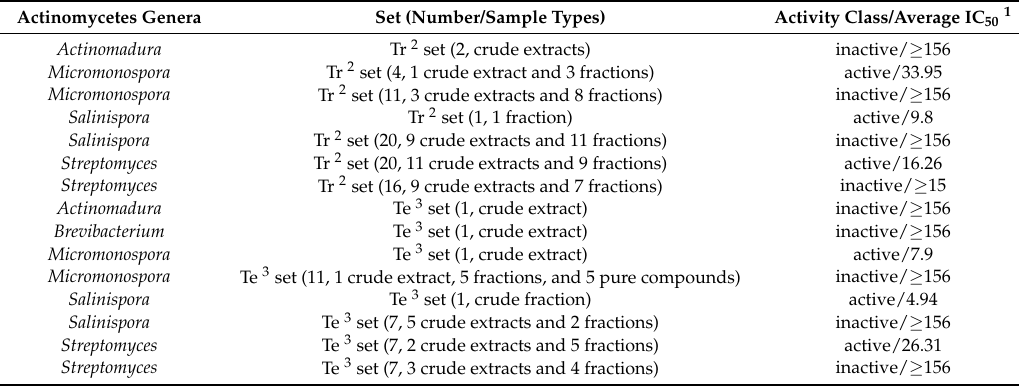
Table 2. Actinomycetes genera and correspondent IC 50 values for